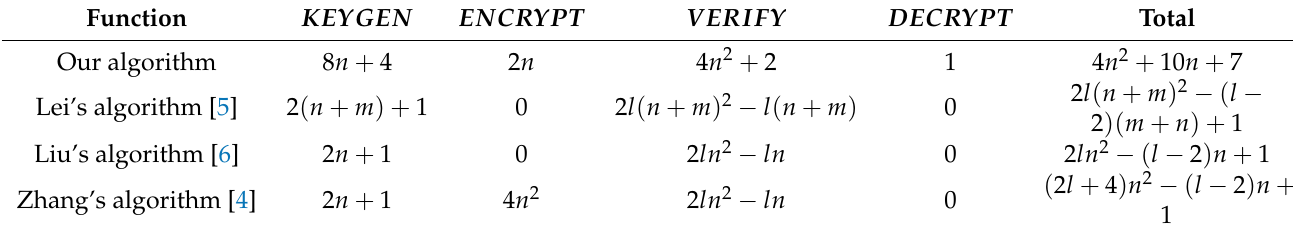
Table 4. Local addition burden.